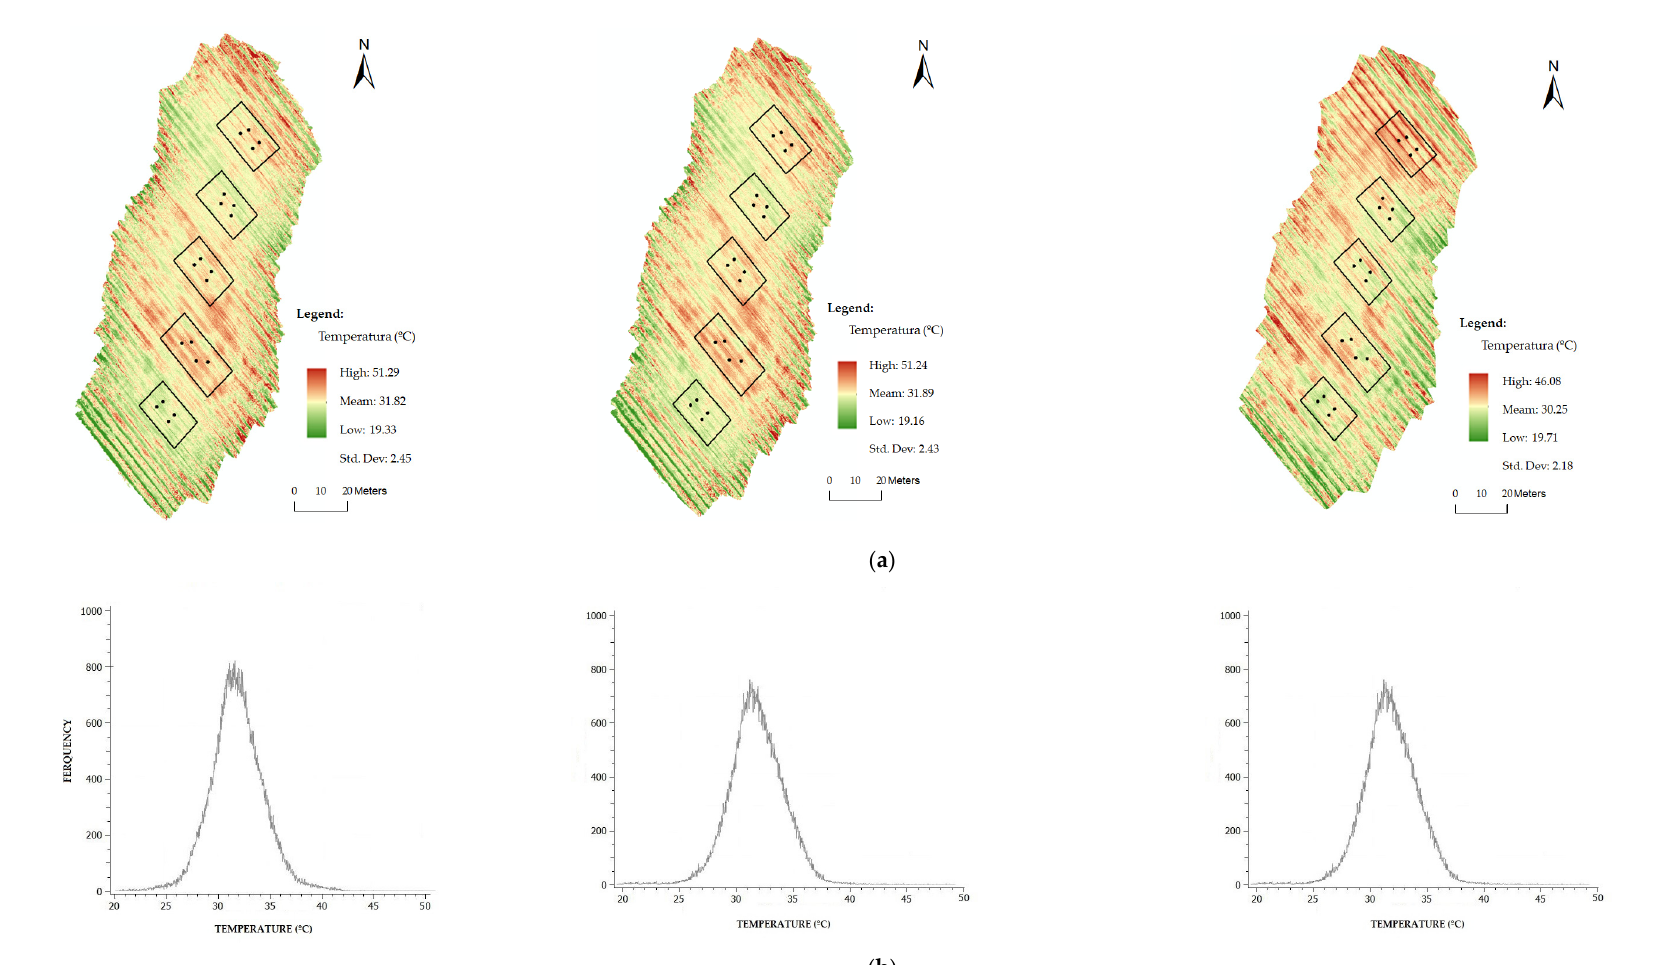
Figure 3. ( a ) Study area thermal orthophoto on different DOY. ( b ) Distribution temperature histogram relative to the soil and